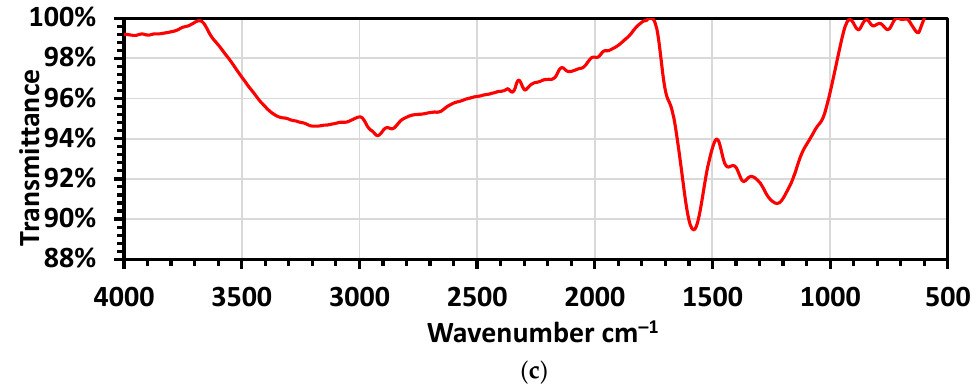
Figure 3. FTIR analysis of ( a ) raw Pea pods – KOH, ( b ) AC-KOH/N 2 /800 °C, ( c ) AC-KOH/CO 2 /800 °C.